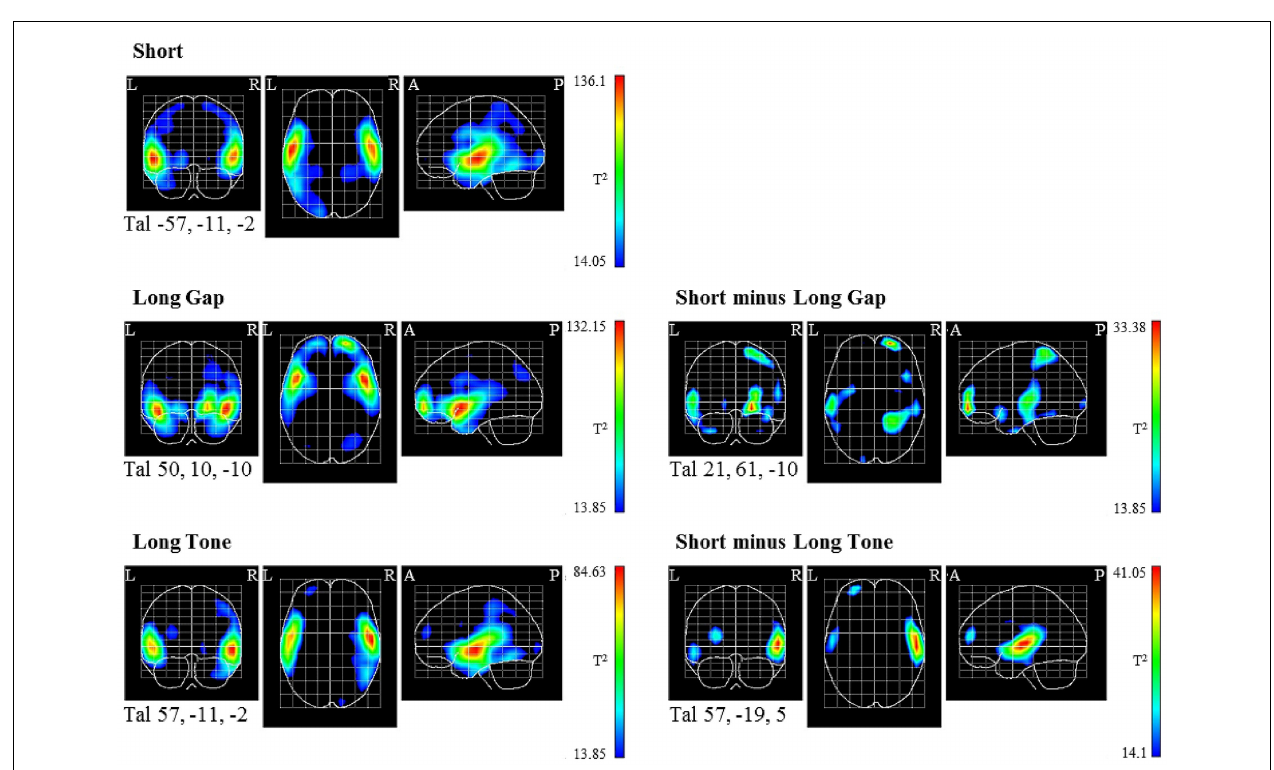
column : surface potential maps (SPMs) of the source reconstructions that were constructed by utilizing a voxel-by-voxel HotellingT 2 -test against 0 separately for each condition. Right column : Source contrasts between conditions based on a voxel-by-voxel HotellingT 2 -test.Tal,Talairach coordinates of the location in which the respective contrast is statistically strongest; R, right; L, left; A, anterior; P,